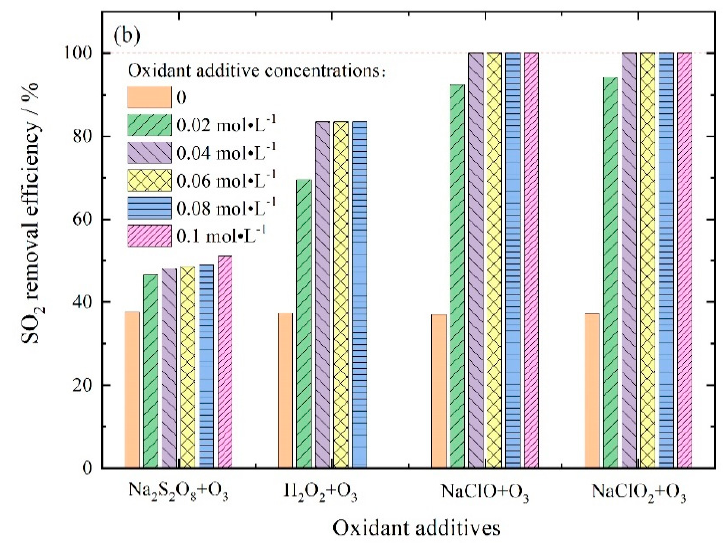
Figure 8. Effects of various oxidant additives in in-situ wet scrubbing solutions on: ( a ) NO x and ( b ) SO 2 removal efficiencies.